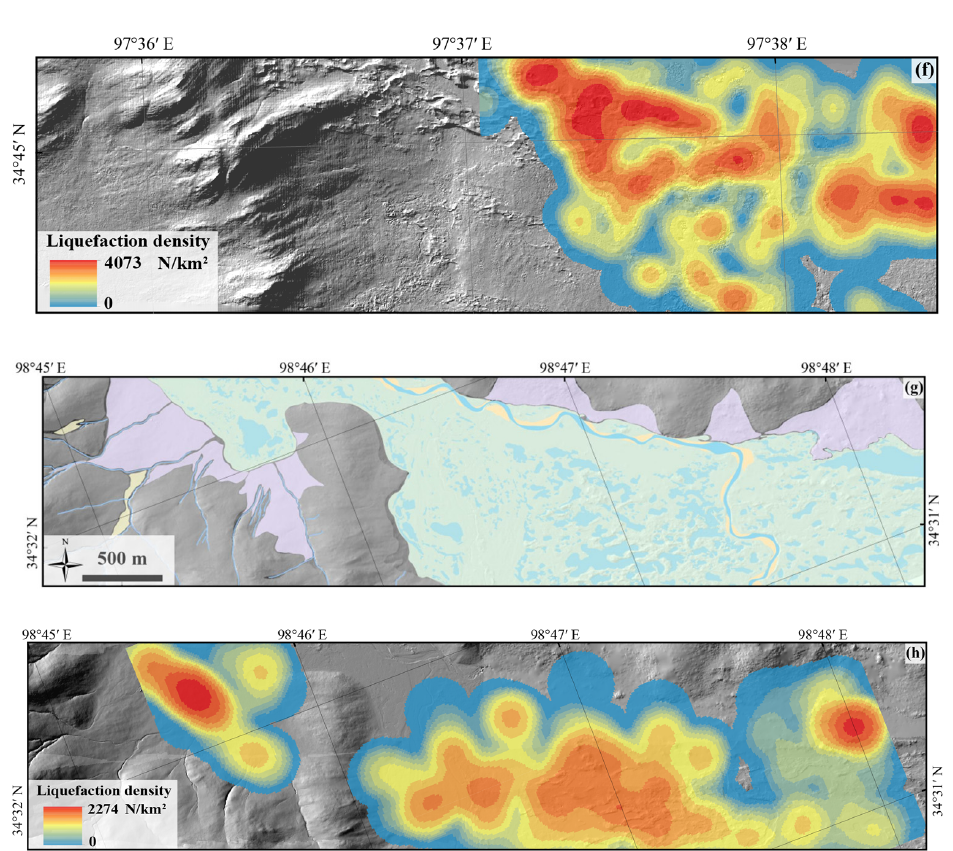
Figure 9. Distribution of liquefaction and depositional environments in W0–5 ( a , b ), W30–35 ( c , d ) and W70–75 ( e , f ) and E35–40 ( g , h ) sections.